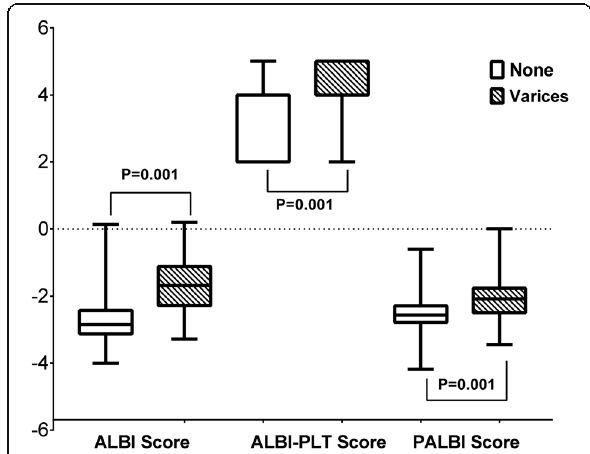
Fig. 1 comparison of ALBI, ALBI-PLT and PALBI in patients with and without esophageal varices